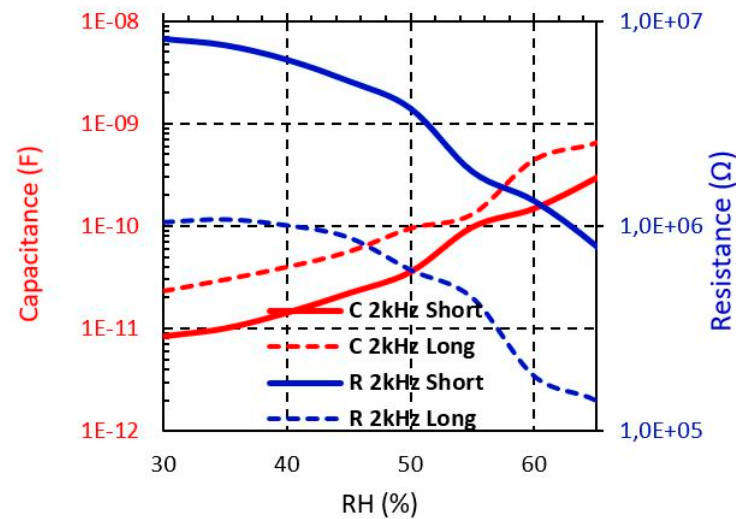
Figure 10. Measured Bekaert (CO-SS) sensors impedance from 30% to 65% RH at different frequencies. Table 3. Measured sensors resistance ranges at 2 kHz.